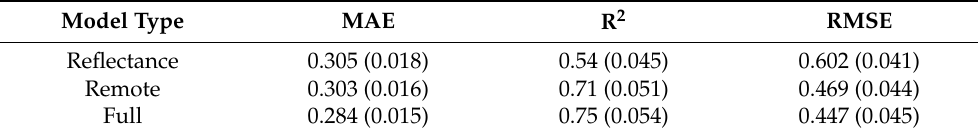
Table 2. Metrics of model accuracy and bias for Reflectance, Remote, and Full model types developed, including Mean Absolute Error (MAE), coefficient of determination (R 2 ), and Root Mean Squared Error (RMSE). Numbers represent the mean and standard deviation in parentheses of each metric for 100 randomly selected test datasets from soils ( n = 1738) collected from nineteen participating ranches encompassing approximately 17,347 ha in the Southern Great Plains ecoregion of the United